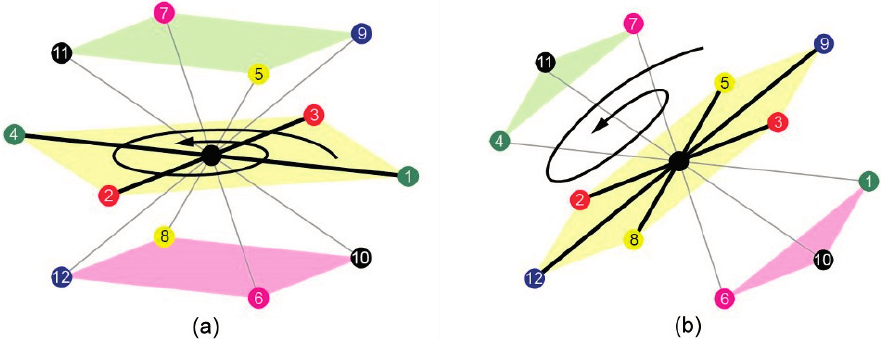
Figure 5. ( a ) Square-based rotation schematic; and ( b ) Triangle-hexagon-based rotation